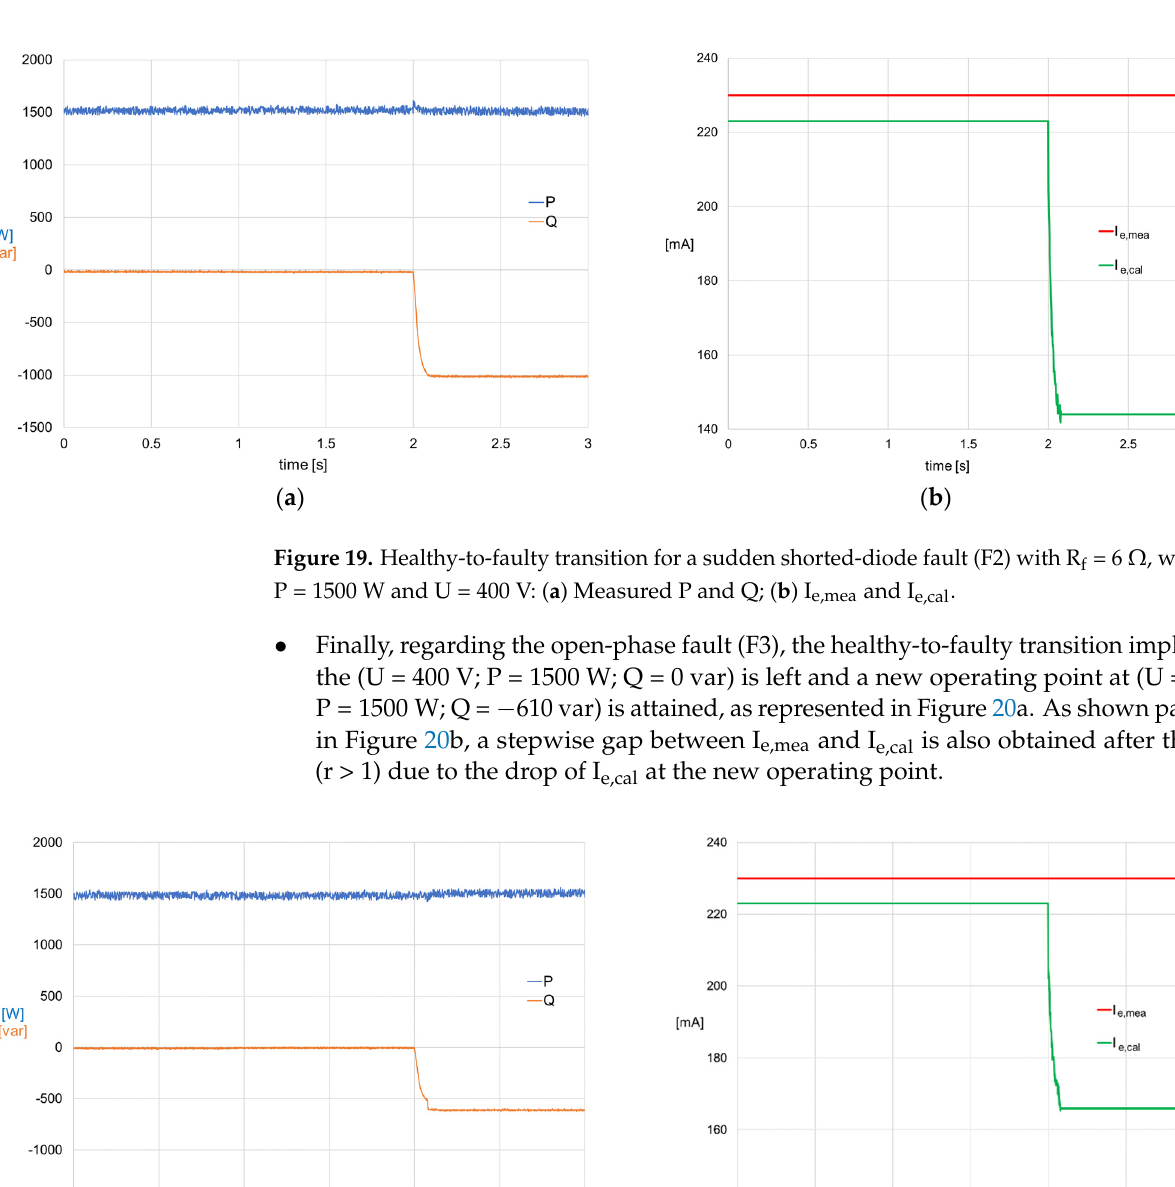
and U = 400 V: ( a ) Measured P and Q; ( b ) I e,mea and I e,cal